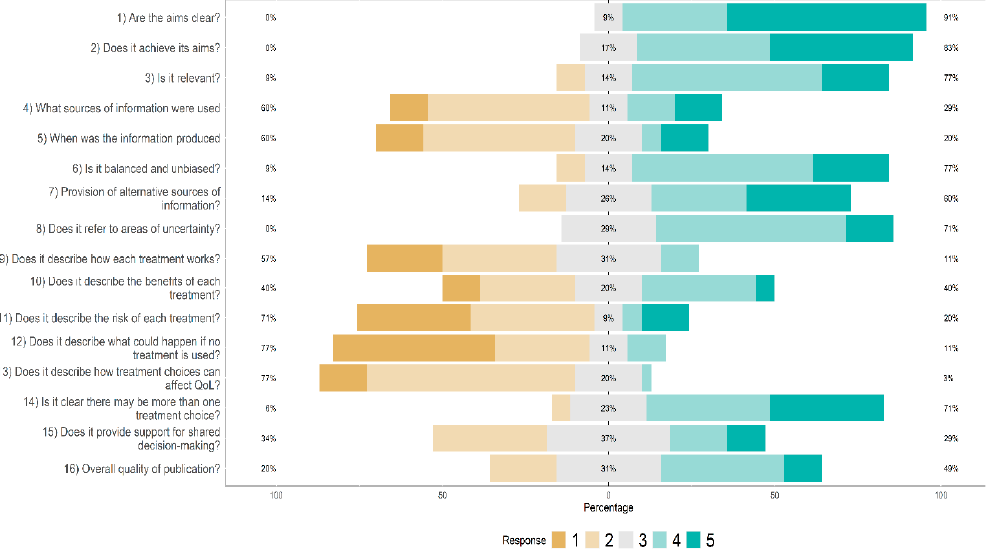
Figure 4. Distribution of DISCERN-scores combined and averaged across Italian websites (1 = low, 5 = high). Adapted from Charnock et al. [72]. 5.7. Information Quality According to BD Treatment Guidelines The English websites explained better and with more details the information related to different treatments of proven effectiveness (Table 2). The Italian websites rarely cited psychosocial interventions and focused more on pharmacological treatment. Compared to the Italian ones, the English websites were more likely to provide a multidimensional view of the available treatments, with a greater attention to psychoso- cial and rehabilitation interventions.